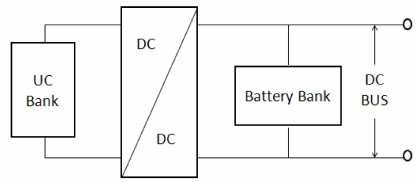
Figure 1. The active parallel HESS